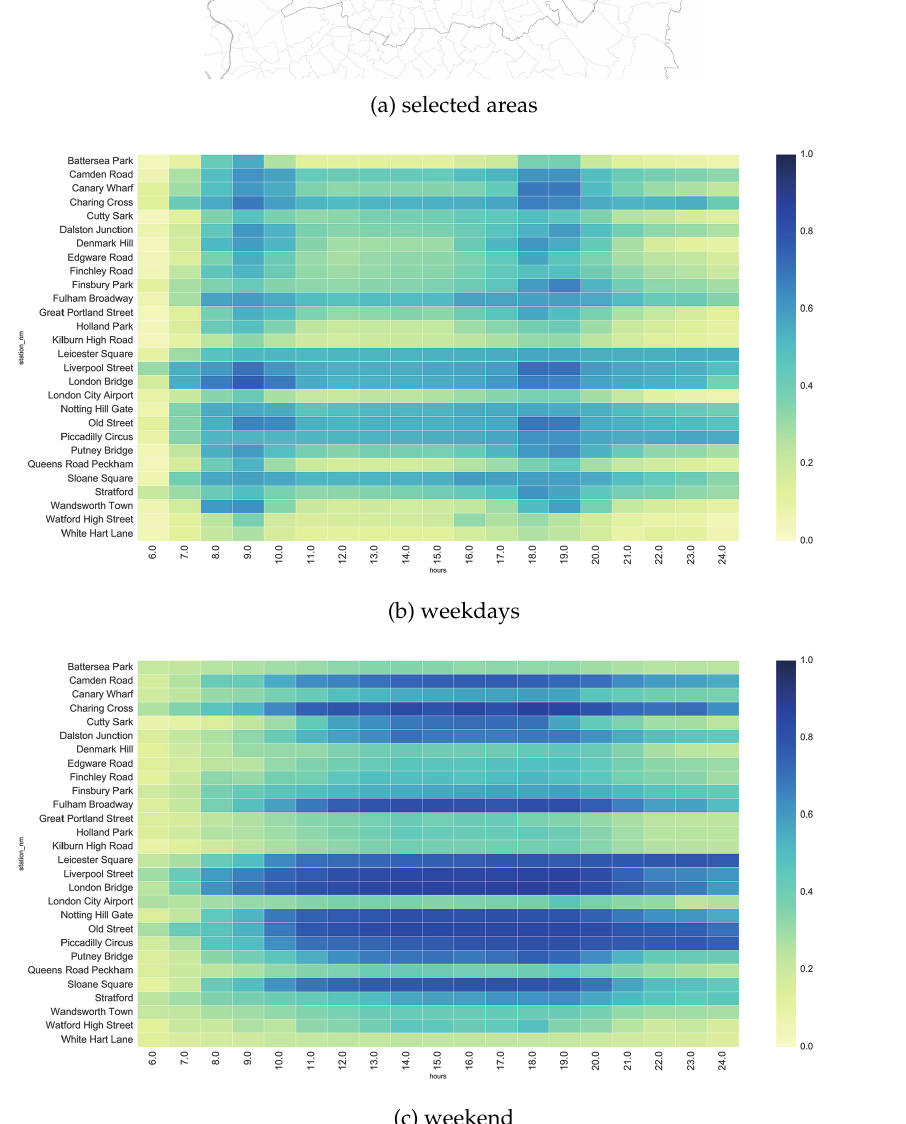
Figure 9: Hourly variation of vitality for selected